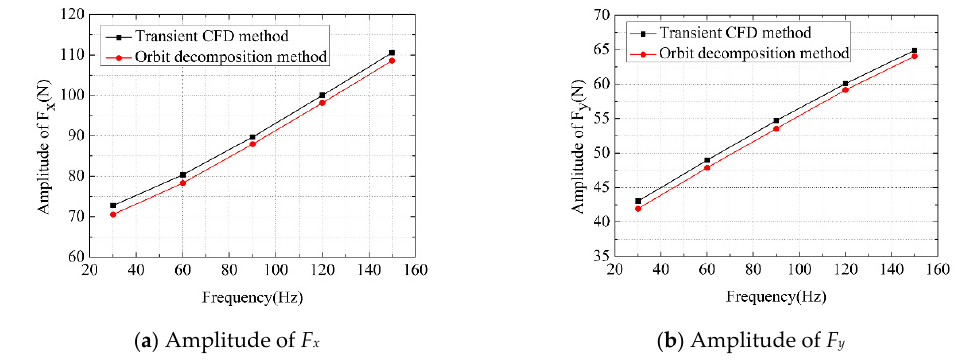
Figure 13. Comparison of fluid-induced force amplitudes. Table 4. Initial phases of time-dependent fluid-induced forces at different whirl frequencies. Frequency